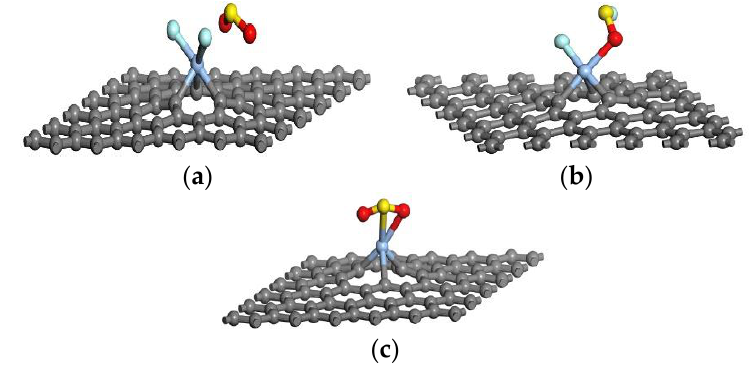
Figure 5. The most stable optimized geometric of single gas molecules interacting with Ag-graphene in ( a ) Ag-graphene/SO 2 F 2 ; ( b ) Ag-graphene/SOF 2 ; and ( c ) Ag-graphene/SO 2 . Table 3. Doping formation energy of the Ag-doped graphene surface.